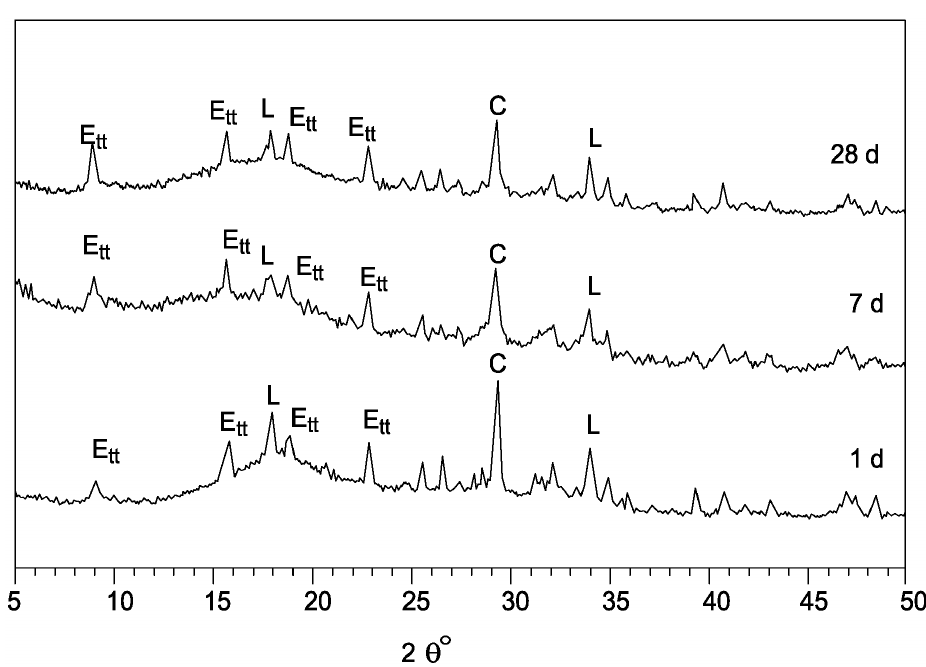
Figure 4. XRD spectra of hydratory system